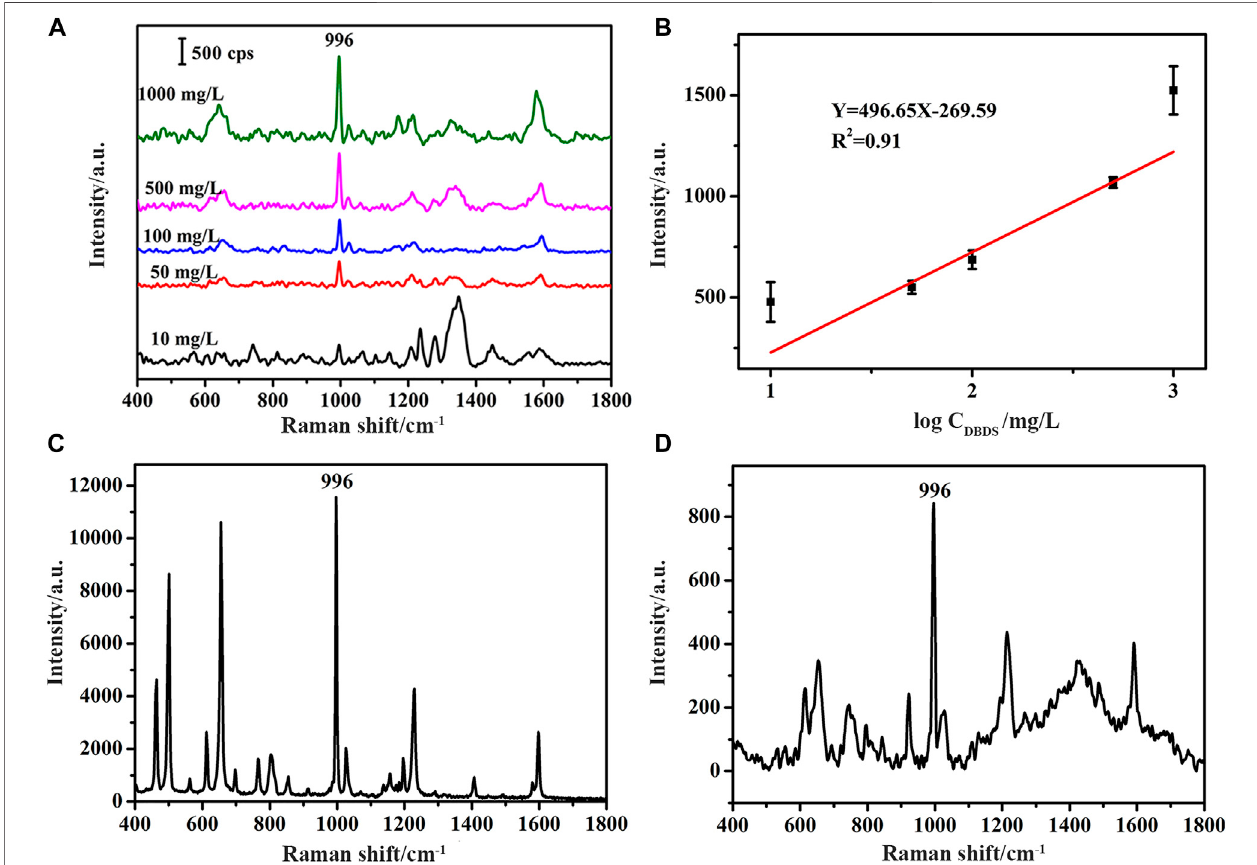
FIGURE 4 | (A) SERS spectra of DBDS standard solutions of different concentrations (10, 50, 100, 500, 1,000 mg/L DBDS in ethanol) (B) The working curve (C) The intrinsic Raman spectrum of DBDS obtained through direct measurements of DBDS powder and (D) The SERS spectrum of the DBDS solution obtained by extracting 3 ml 1 mg/L DBDS in insulating oil with 300 µL 3-methylpyrrolidone.